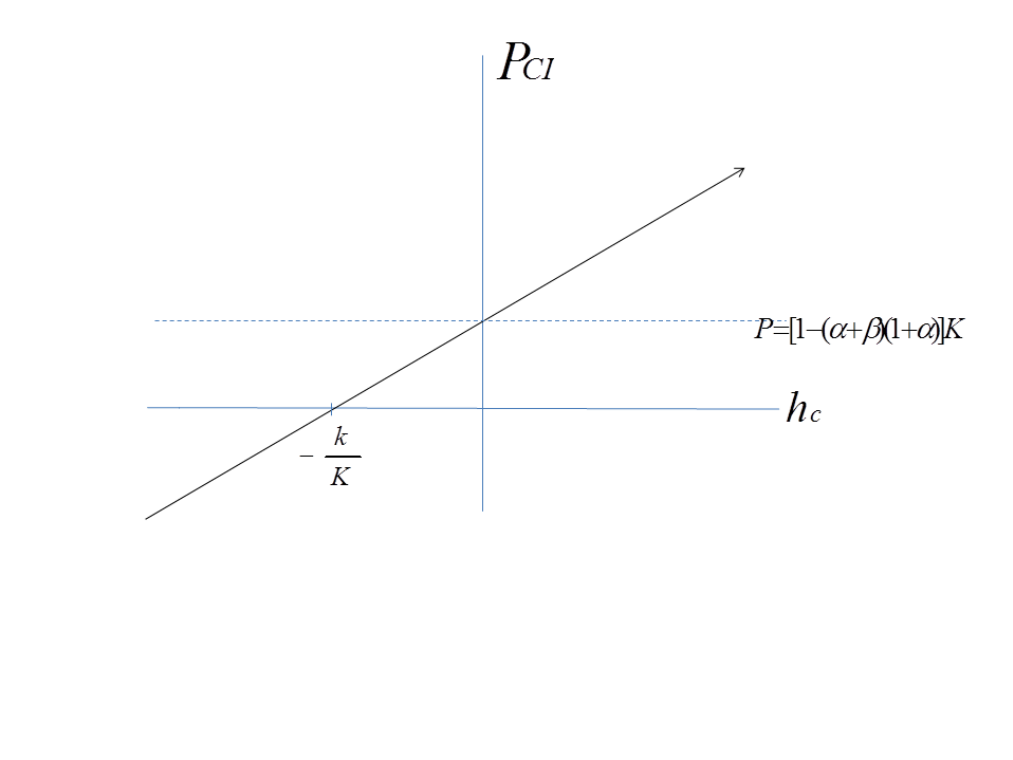
The optimal price for CI and the